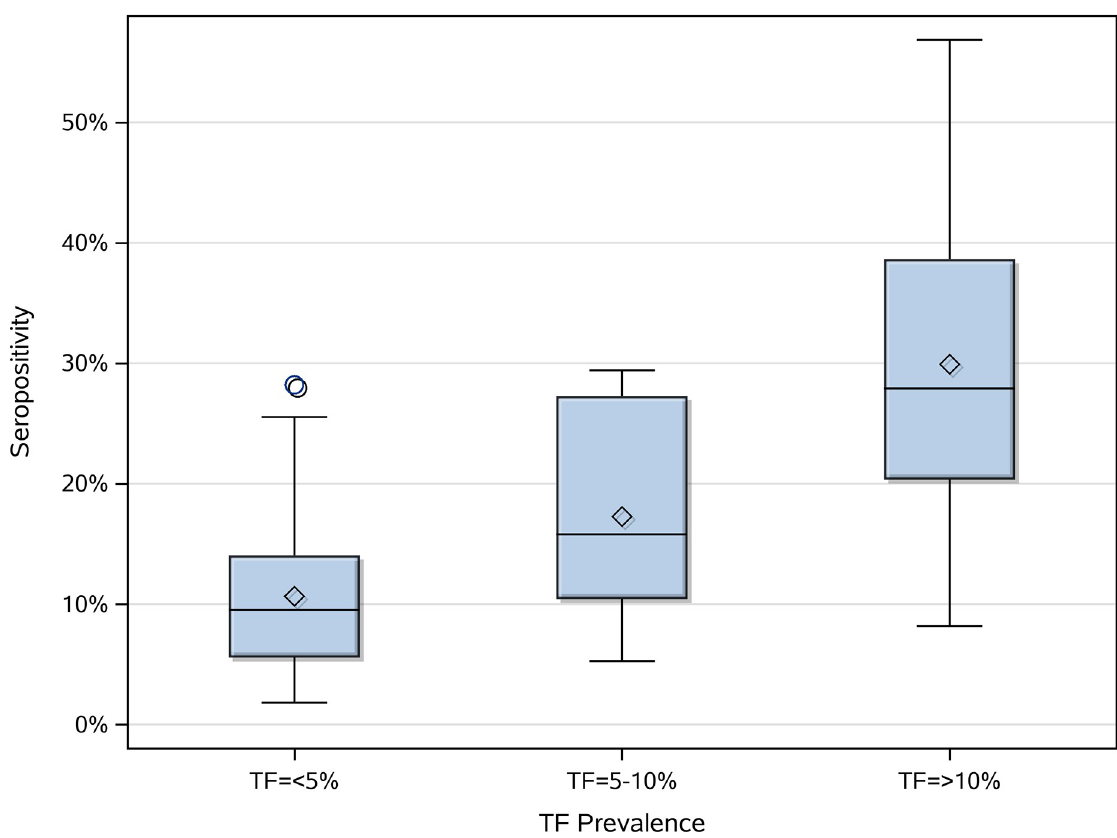
Fig 3. Village-level percent seropositivity by category of village TF endemicity in children ages 1–9 years. The horizontal line within each box represents the median, and the diamond represents the mean.